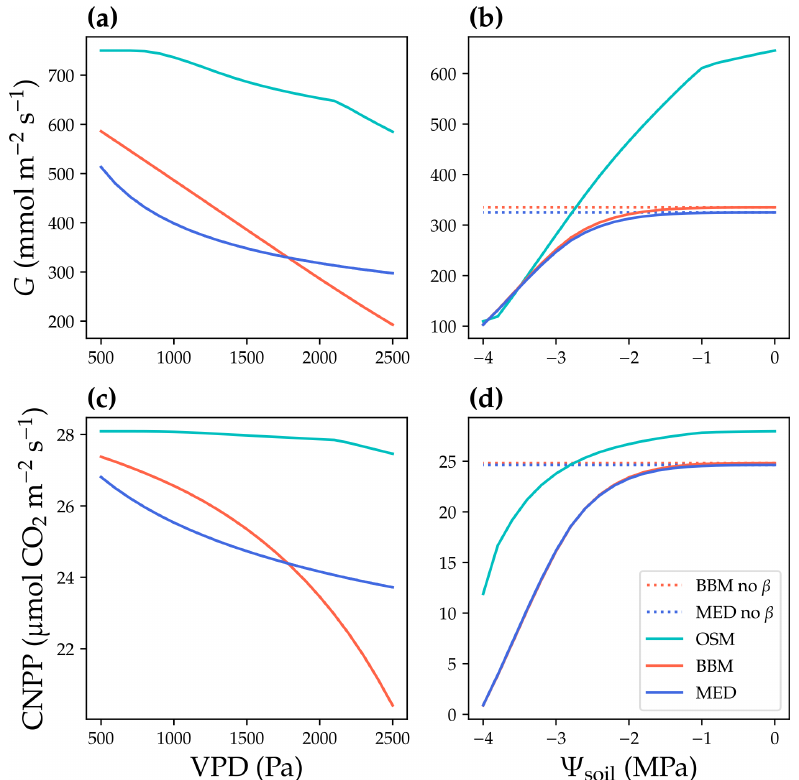
Figure 6. Responses to environmental cues of three stomatal models. The stomatal models are the Ball et al. (1987), Medlyn et al. (2011), and Wang et al. (2020) stomatal model predictions (BBM, MED, and OSM, respectively). (a) Canopy cumulative stomatal conductance per ground area ( G ) response to the atmospheric vapor pressure deficit (VPD). The red and blue dotted lines plot the responses of the BBM and MED models without a tuning factor ( β ) for photosynthetic capacity, respectively. The red and blue solid lines plot the response of the BBM and MED models with a tuning factor for photosynthetic capacity (Eq. 8), respectively. The cyan solid line plots the response of the OSM model. The turning point around VPD = 1400Pa is because leaf stomatal conductance hits the maximum structural limitation (0.2molm − 2 s − 1 in the example). (b) G responses to soil water potential ( (cid:57) soil ). (c–d) Canopy net primary productivity per ground area (CNPP, total canopy net photosynthetic rate per ground area, gross primary productivity minus canopy leaf respiration) responses to the VPD and (cid:57) soil